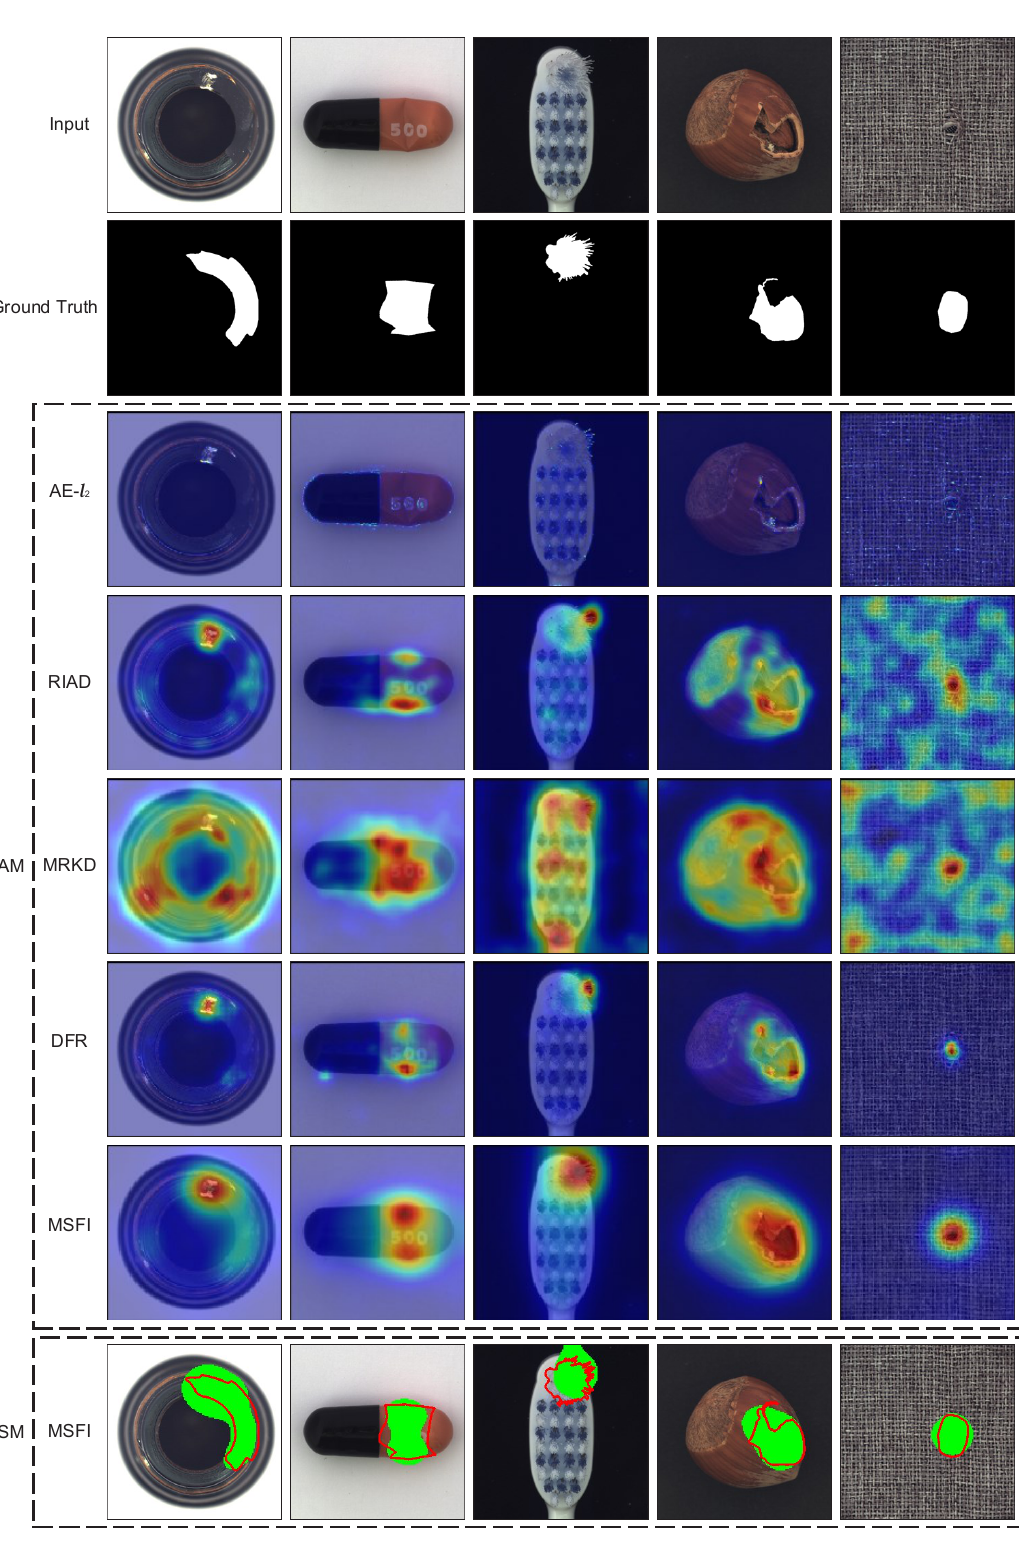
Figure 5. Qualitative comparison between the proposed method and other methods on MVTec AD dataset. Input represents the input abnormal image. Ground Truth represents the actual abnormal regions (in white). AM represents the anomaly map. SM represents the segmentation map. The red region represents the high anomaly score of AM, the solid red line indicates the boundary of the actual abnormal region and the green region represents the predicted abnormal region in